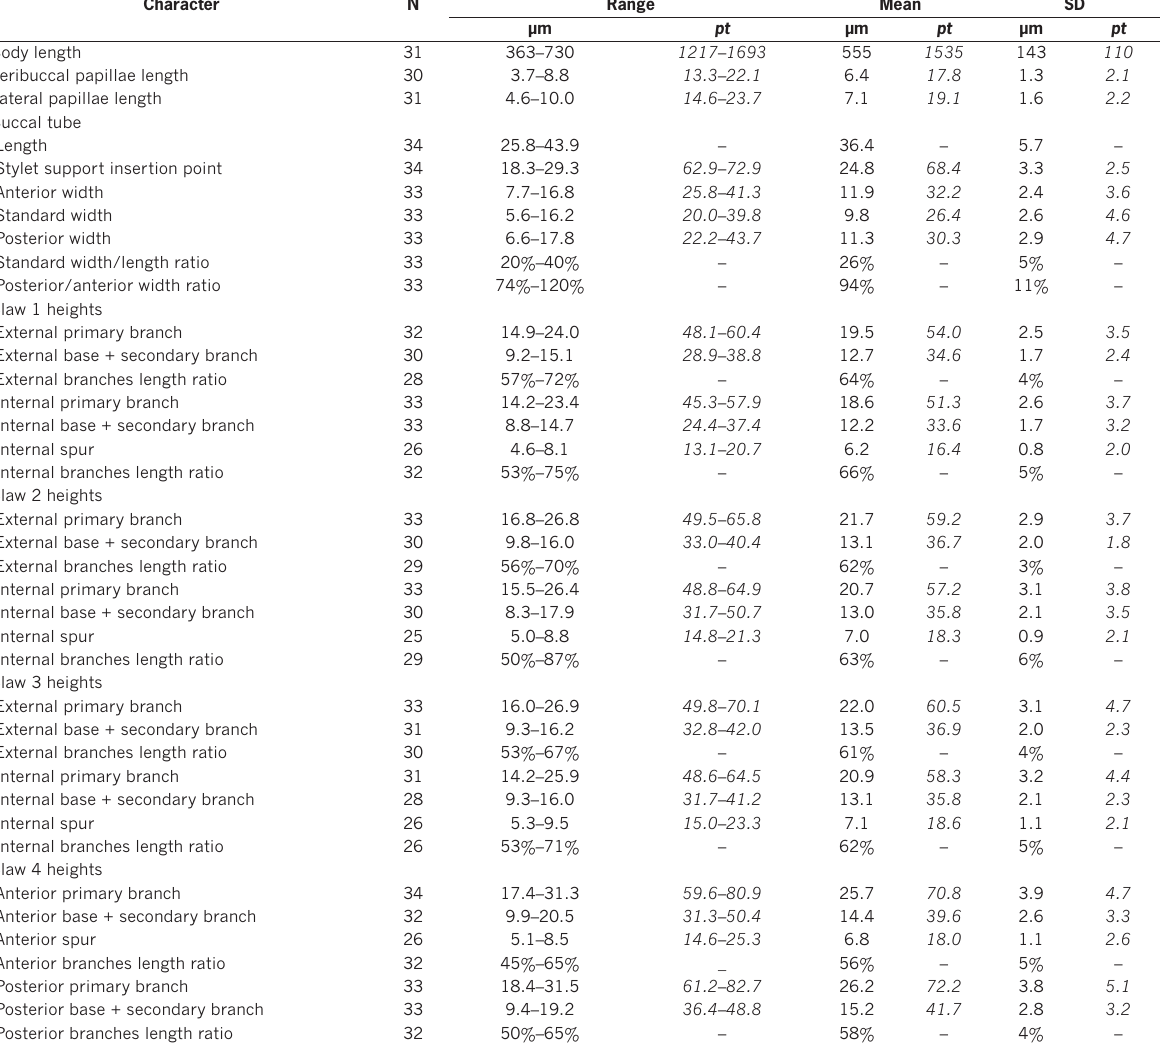
Table 4. Joined measurements (in μm) and the pt values of selected morphological structures of 34 adult females of Milnesium reductum Tumanov, 2006 from five populations from Kyrgyz Republic, KG.012; KG.013; KG.014, KG.142 and KG.147, mounted in Hoyer’s medium. Individuals were chosen to represent the entire body length range, with as equal representation of all available life stages as possible (N – number of specimens/structures measured, RANGE refers to the smallest and the largest structure amongst all measured specimens; SD – standard